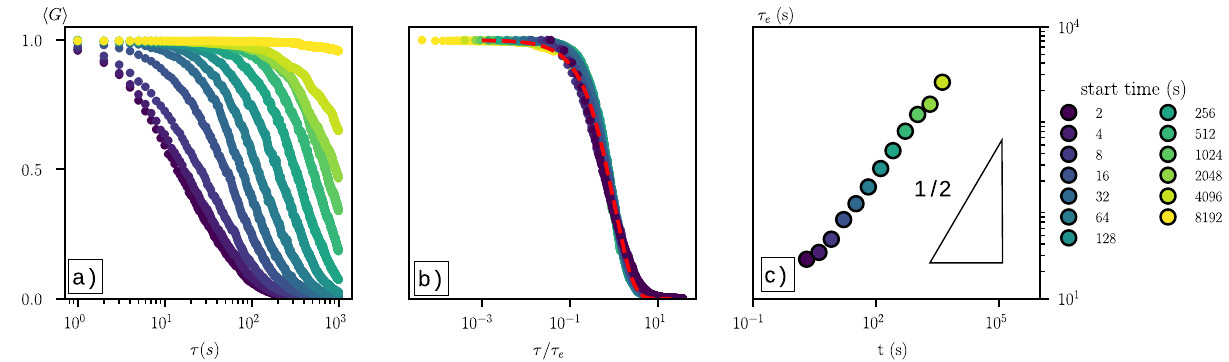
Fig. 3 Glassy relaxation in an undisturbed granular heap. a Spatially-averaged correlation function 〈 G 〉 for 13 start times. Start times mark the distance from the cessastion of surface fl ow and the preparation of the pile. b Data are reasonably collapsed by τ e ; red dotted line indicates exponential decay. c Growth of the relaxation timescale, with a slope of 1/2 shown for reference. Data may be fi t with aleast-squares regression of τ e ¼ τ e